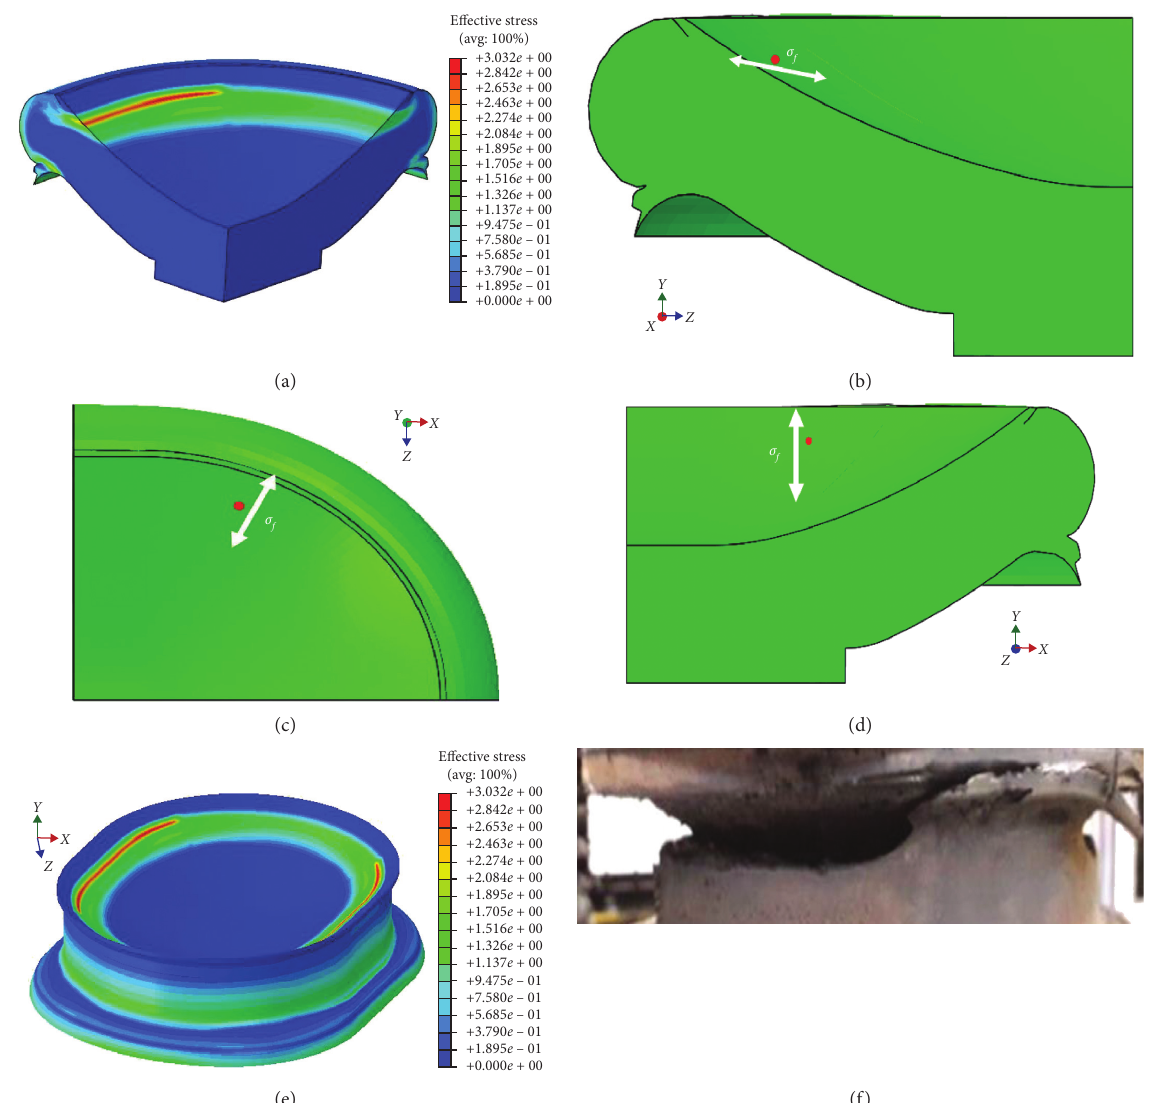
Figure 4: The profile and the orientation of the effective stress with the failed profile at the top interface of the whole buffer. (a) The effective stress profile of the top interface of the buffer. (b) The effective stress direction at the hot spot of the top interface in the YOZ plane ( − 7.7 ° from Z). (c) The effective stress direction at the hot spot of the top interface in the XOZ plane ( − 61.8 ° from X). (d) The effective stress direction at the hot spot of the top interface in the XOY plane (82.9 ° from X). (e) The hot spots at the top interface of the whole buffer. (f) The failed top interface of the